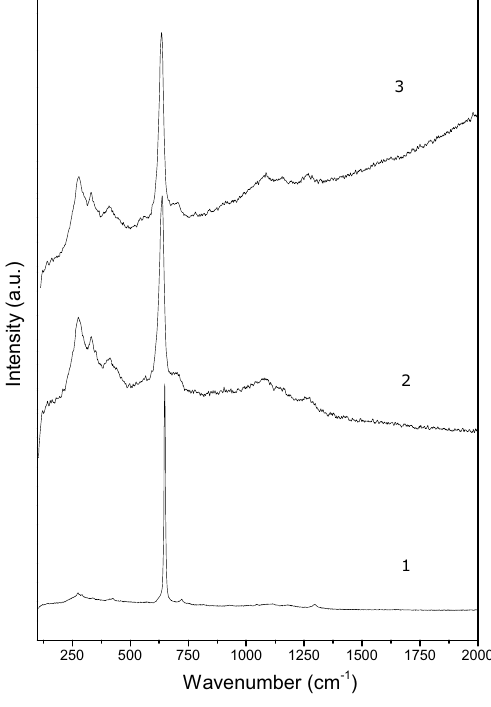
Fig. 3 – Micro-Raman spectra of the decomposition products after heating compounds 1-3 at 1000 ◦ C.